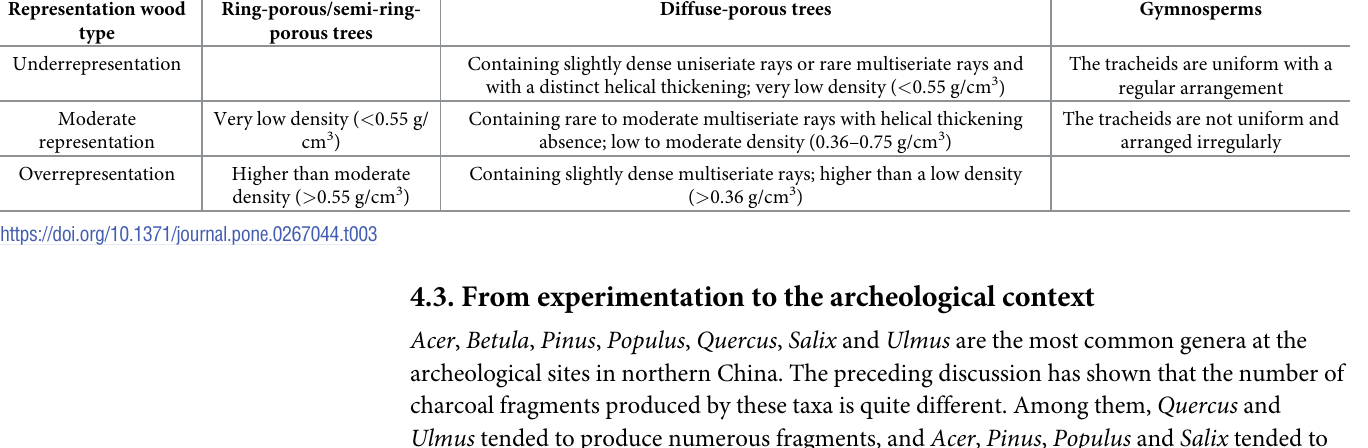
Table 3. Relationship between wood/charcoal texture and representation. Representation wood